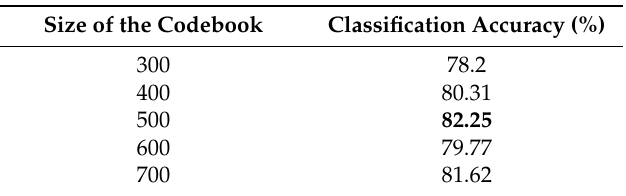
Table 5. Average classification accuracy of the SIFT over neuroblastic tumour dataset using different codebook sizes. Bold value indicates the highest classification accuracy.